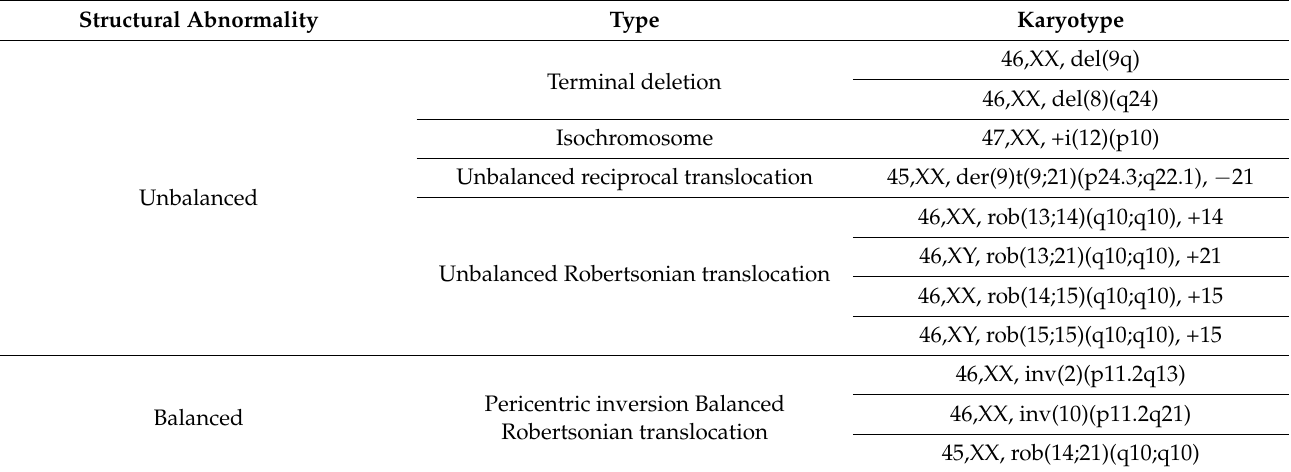
Table 3. Structural abnormalities detected.